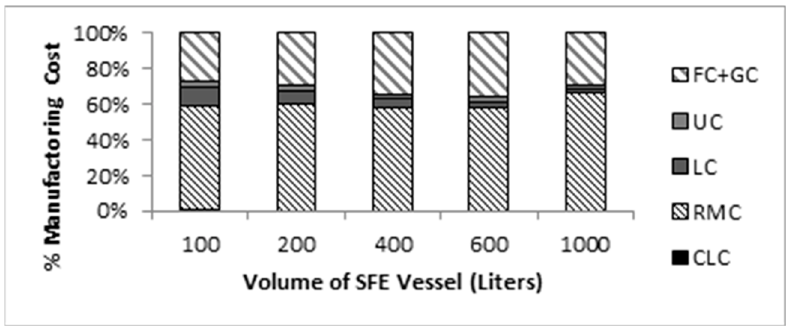
Figure 6. Each cost category in the manufacturing cost of Pistacia lentiscus supercritical extract.